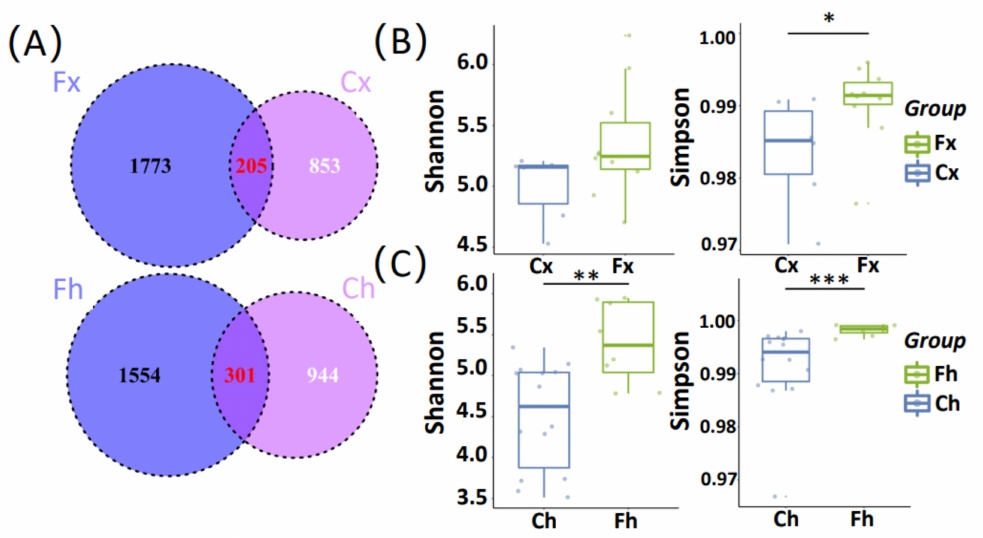
Figure 2. Analysis of the composition and diversity of intestinal microbes. Fx, free-range yaks in Xinghai County; Cx, captive yaks in Xinghai County; Fh, free-range yaks in Haiyan County; Ch, captive yaks in Haiyan County. ( A ) Venn diagram showing the OTU overlap of Fx and Cx and Fh and Ch, respectively; ( B ) Shannon index and Simpson index of Fx and Cx; ( C ) Shannon index and Simpson index of Fh and Ch. Statistical test results are represented by p -value (* p < 0.05, ** p < 0.01, *** p <